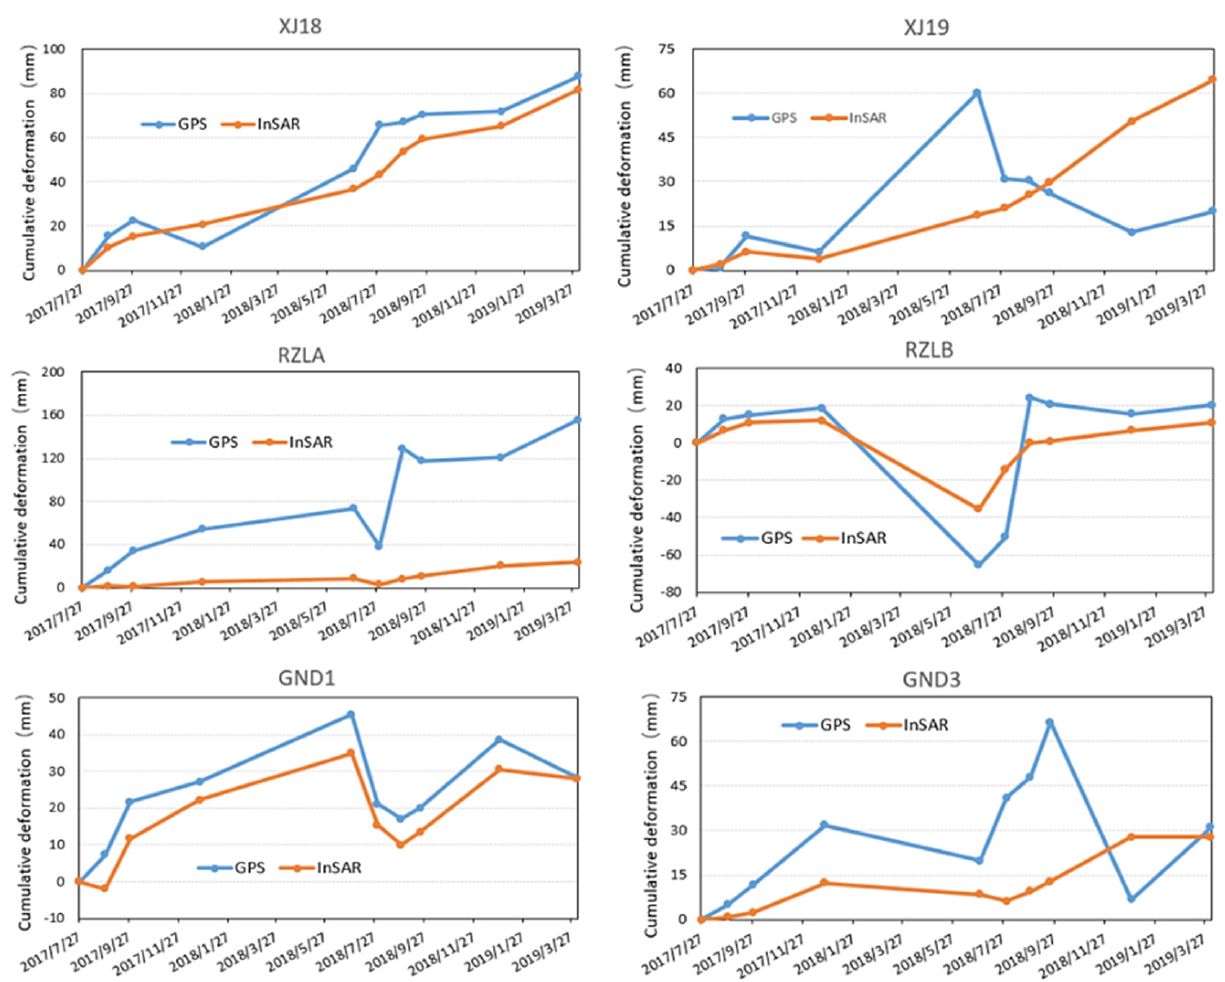
Figure 17. Comparison of DS-InSAR and GPS survey results of XJ landslide from July 2017 to March 2019